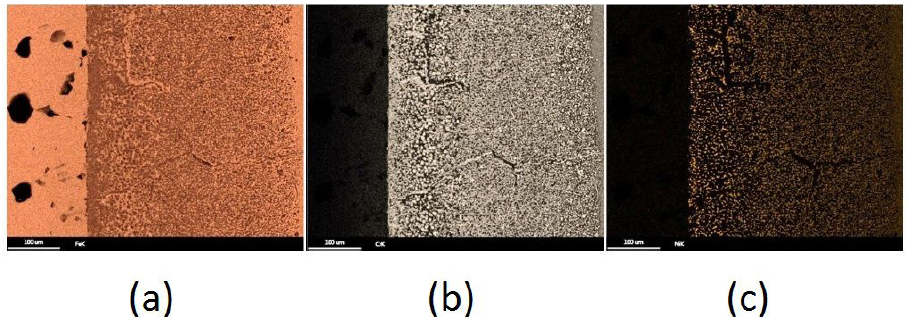
Figure 11. EDS maps of AISI 348 sample after 5 min oxidation at 1300 °C showing (a) Fe, (b) Cr, and (c) Ni profiles. The outer layer is on the left side 26